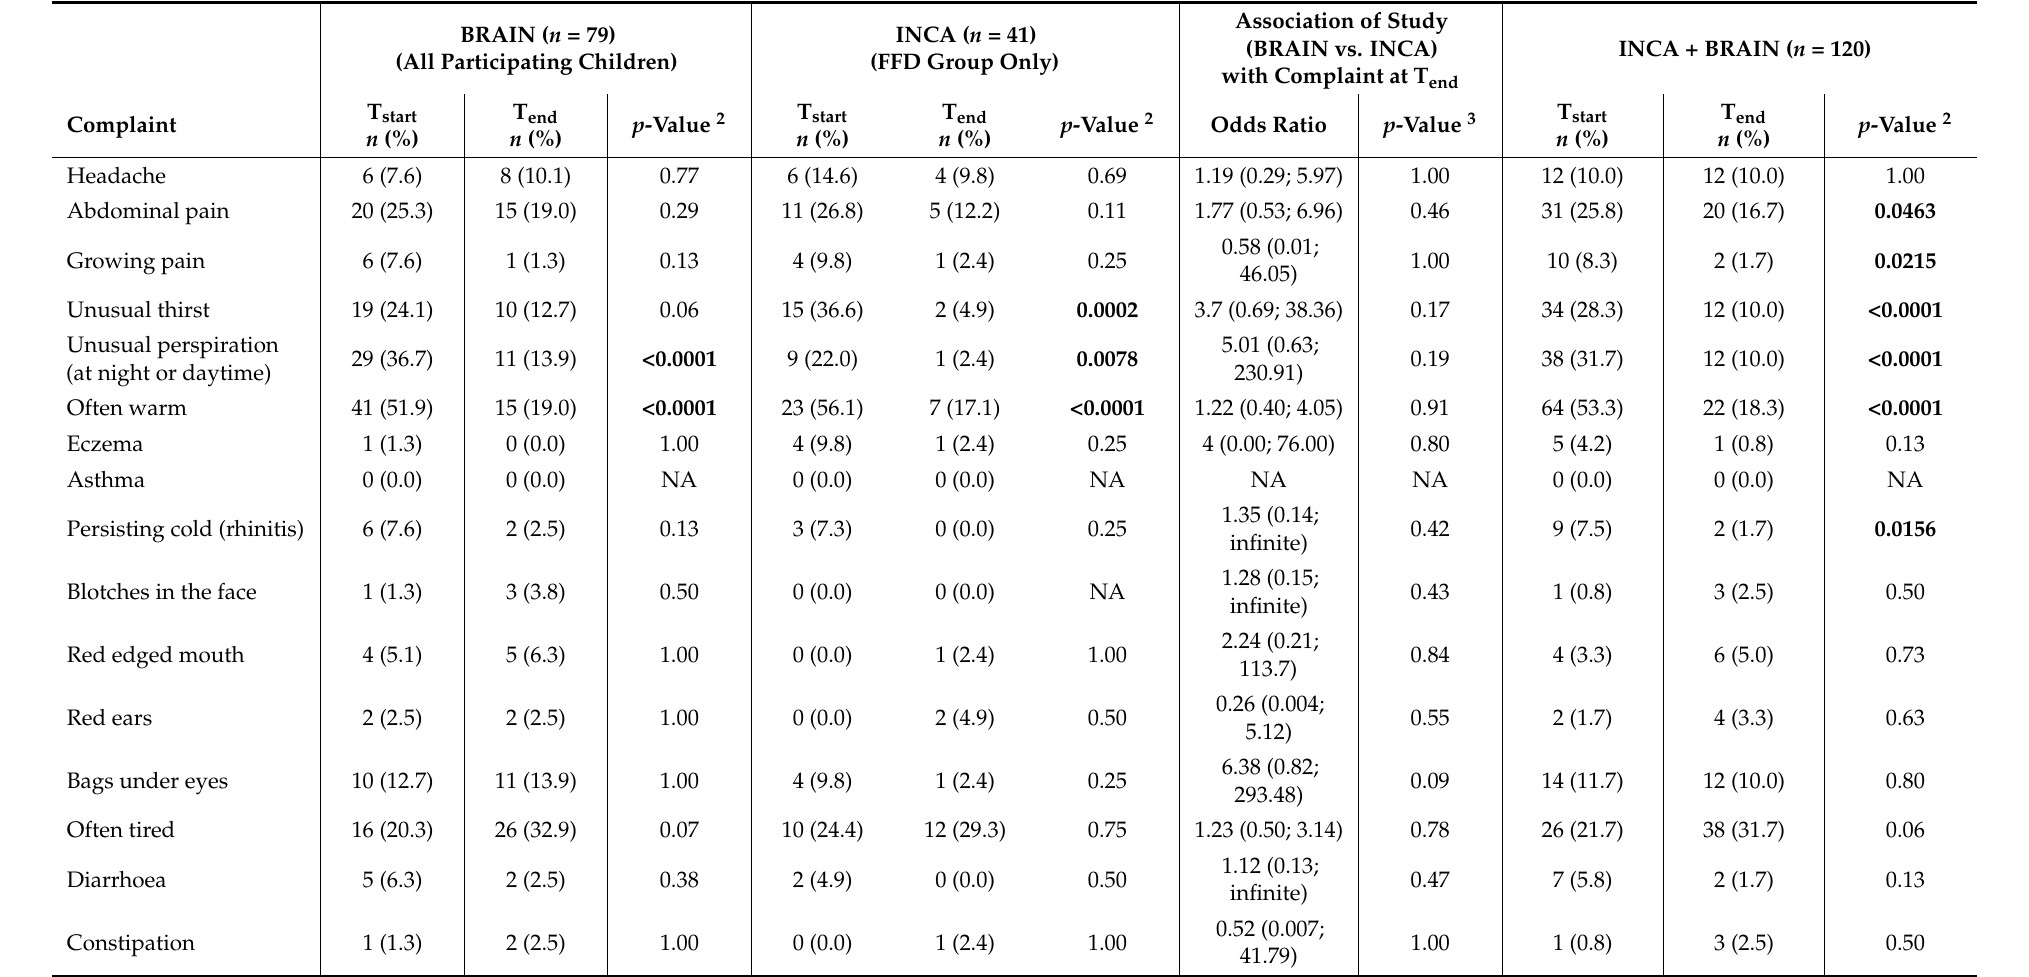
Table 4. Distribution and statistical analysis of the presence of 21 physical complaints in the INCA and BRAIN studies, scored using the physical complaint questionnaire 1 before (T start ) and after (T end ) following the few-foods